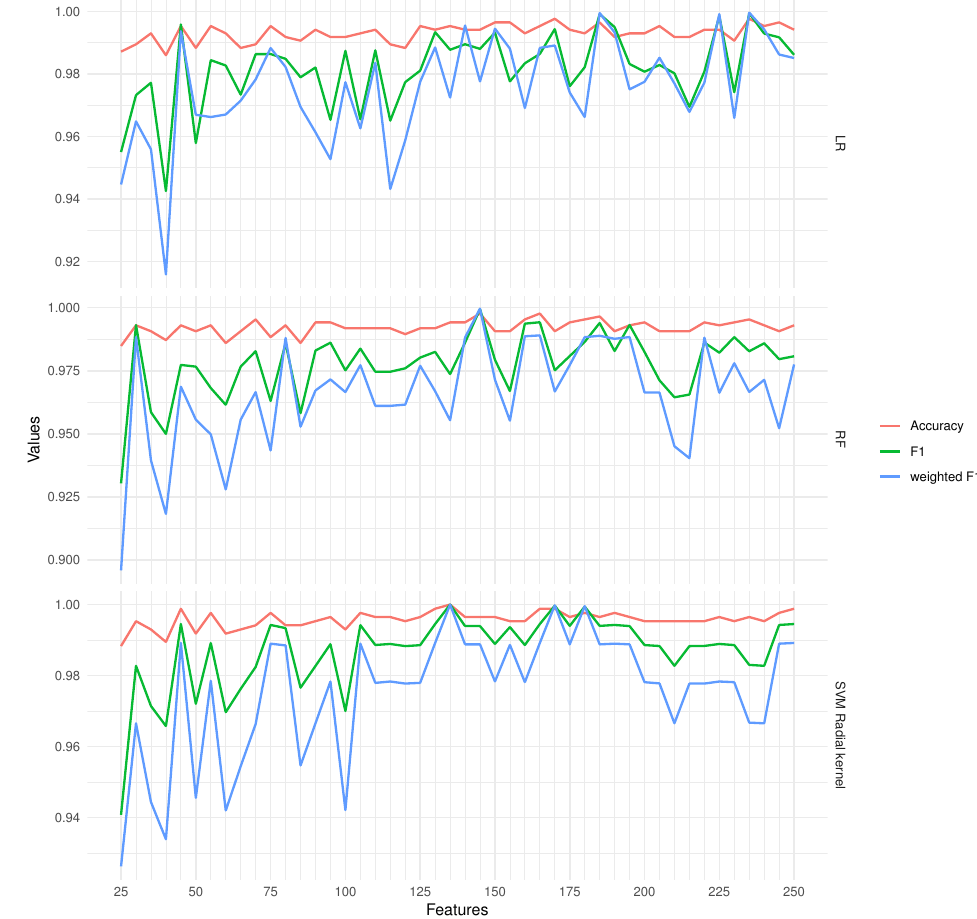
Figure 6. The performances of the classification versus the number of features.